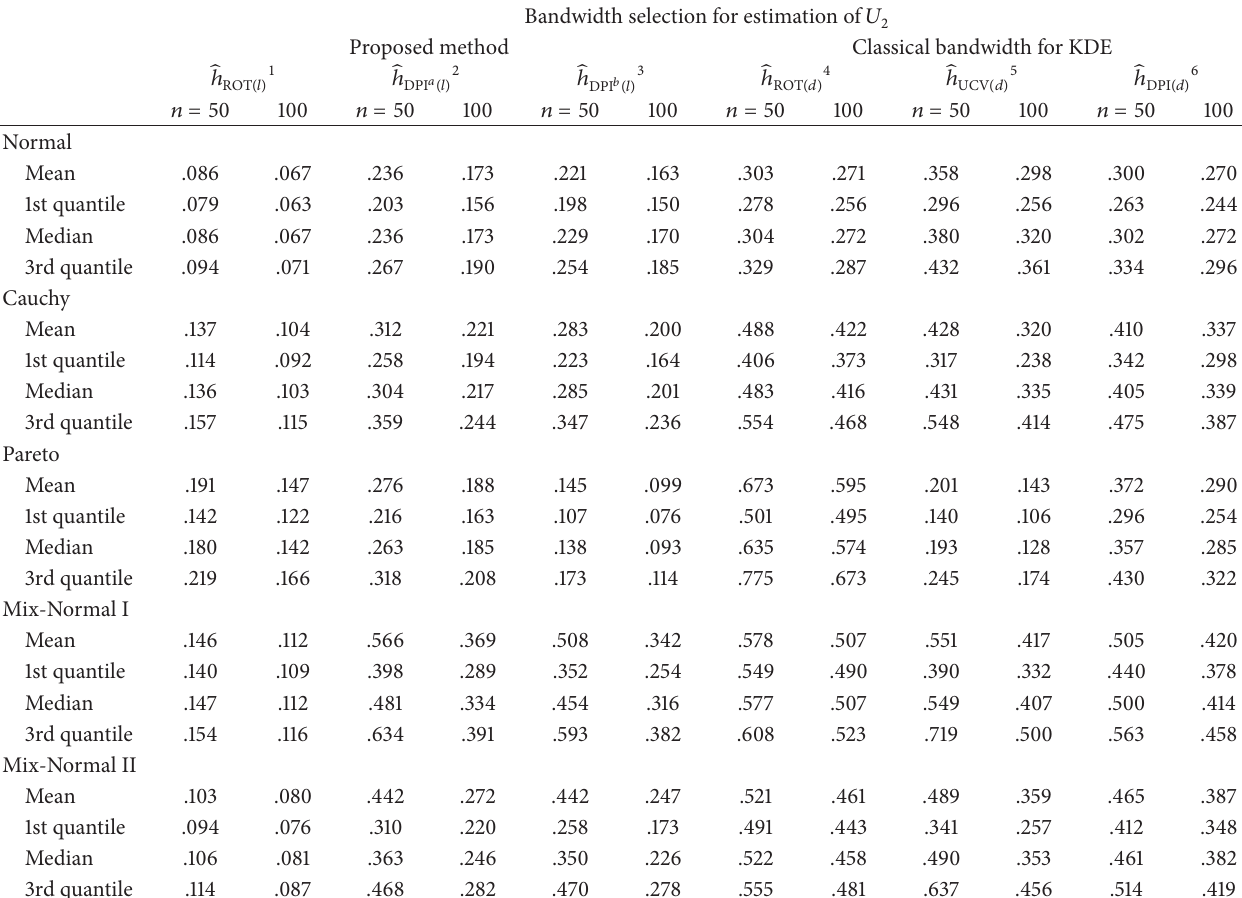
Table 2: Optimal bandwidth selection in estimation of 𝑈 2 with comparison to classical bandwidth selection